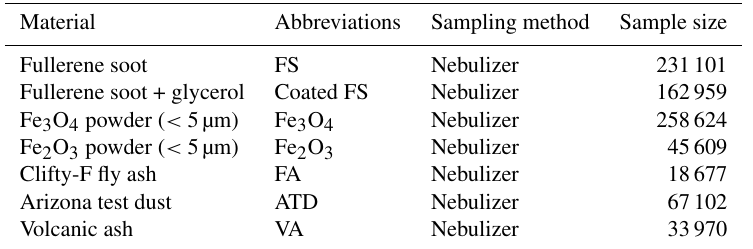
Table 1. Laboratory aerosol samples used in analysis. We test different aerosols with known incandescent components, given in the table below. The abbreviations used to refer to these materials throughout this work are given in the second column. The sample size refers to the total number of incandescing aerosols in the sample.